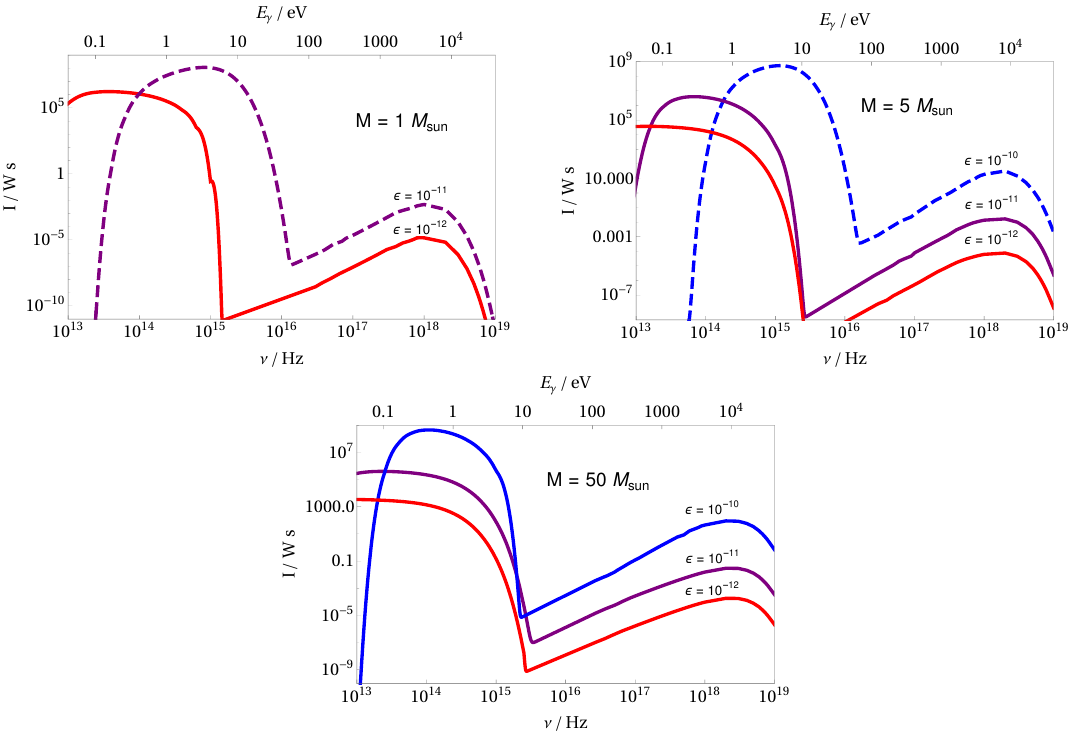
Figure 6 . Nugget emission spectra for all of the benchmarks we consider. We plot the intensity per unit frequency in Watt-seconds as a function of photon energy. Solid lines indicate benchmarks for which the nugget is optically thin, while dashed lines indicate optically thick benchmarks. Attenuation at low frequencies is due to free-free absorption by mirror electrons, hence is more pronounced at higher values of (cid:15) . We do not show the spectra from the 1 solar mass (cid:15) = 10 (cid:0) 10 benchmark, since, as explained in the text, the total predicted luminosity is greater than the luminosity of the star, signaling that our assumptions of ignoring the e(cid:11)ect of the SM nugget on the Mirror Star itself have broken